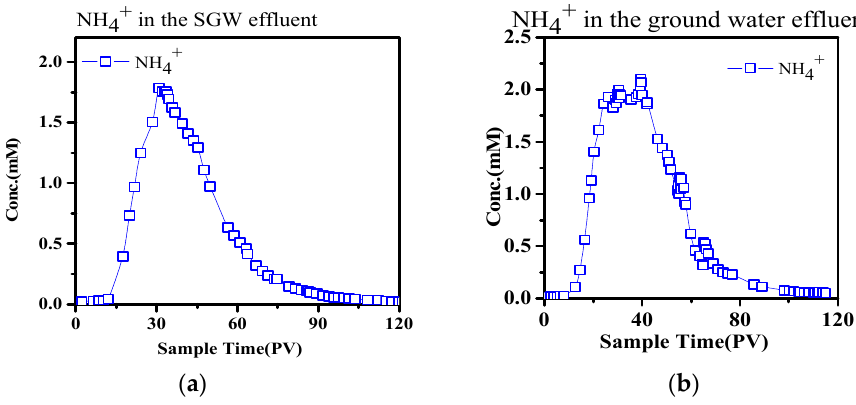
Figure 2. The kinetic curves of NH 4+ in the ground-water effluent under aerobic conditions ( a ) and anaerobic conditions ( b ).